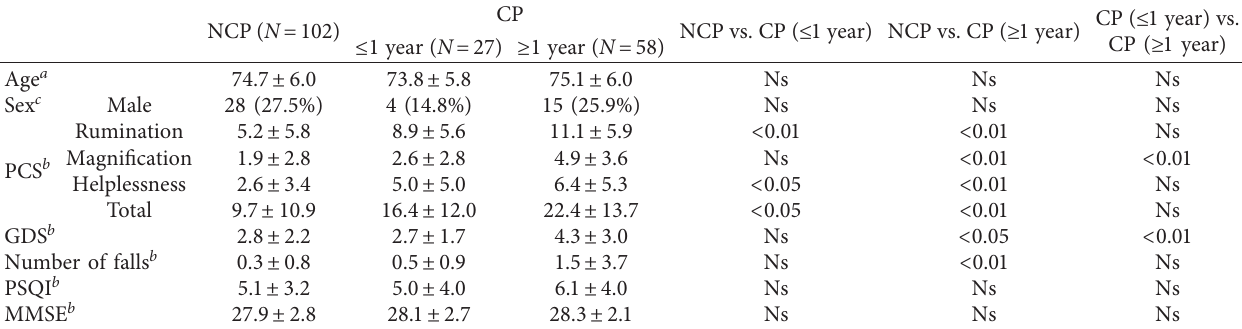
Table 3: Comparisons between nonchronic pain, chronic pain (less than 1 year), and chronic pain (more than 1 year)